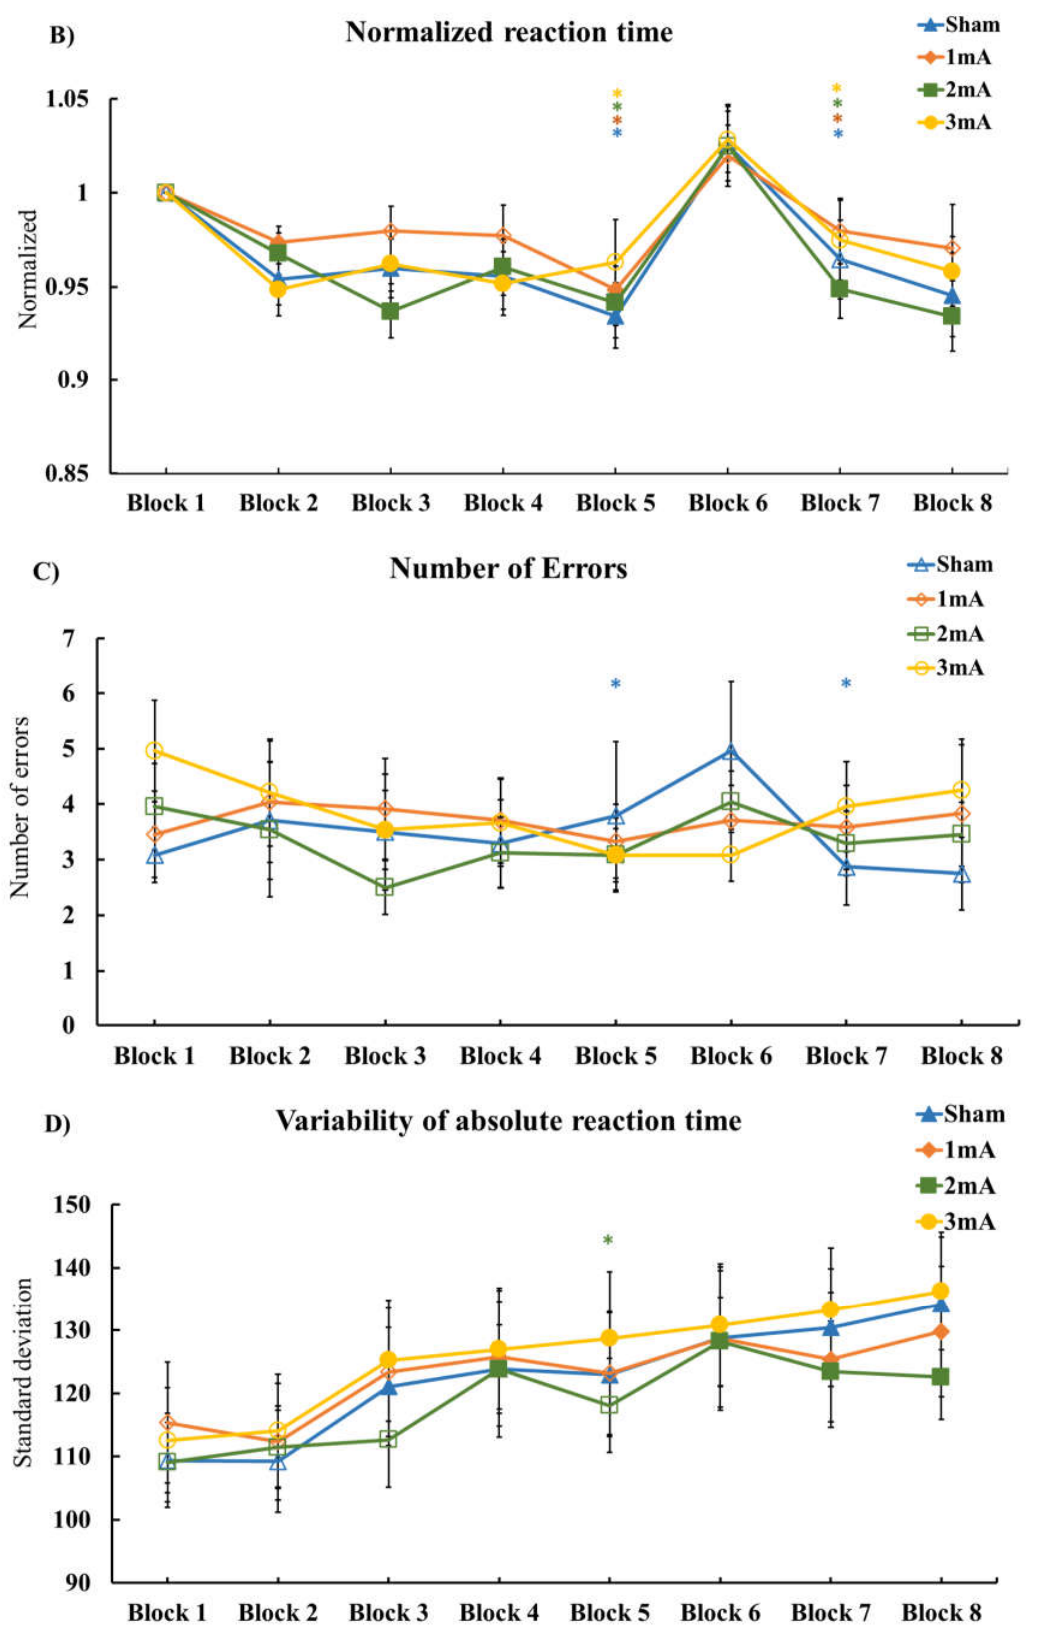
Figure 2. Results of the M-SRTT. The graphs show results for ( A ) absolute RT, ( B ) normalized RT, ( C ) number of errors, and ( D ) variability of absolute RT across different tDCS protocols. Filled symbols indicate a significant difference compared to block 1 in each condition. Asterisks ( ⁎ ) refer to